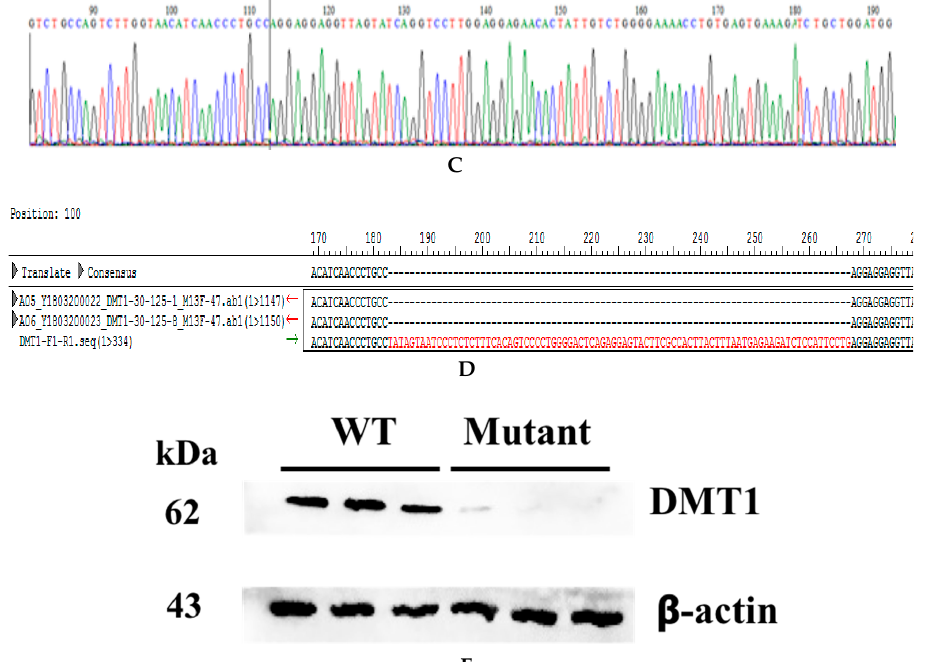
Figure 1. Validation of DMT1-knockout Caco-2 cell line. ( A ) The electrophoresis results of the target fragments of DMT1 in the transfected cells; ( B ) Partial sequencing results of the target fragment on DMT1 of wild-type Caco-2 cells; ( C ) Partial sequencing results of the target fragment on DMT1 of the mutant cells; ( D ) Sequence comparison of the target fragment of DMT1 in the mutant and wild-type Caco-2 cells; ( E ) Western blot results of DMT1 in wild-type Caco-2 cells and the mutant cells.